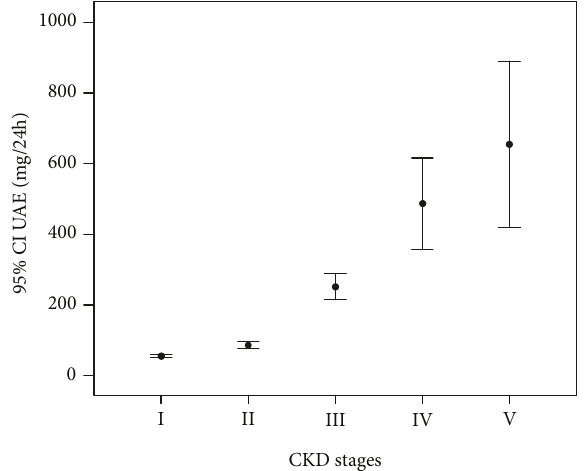
Figure 2: The mean and 95% CI of UAE in 5936 participants in type 2 diabetes without overt thyroid dysfunction according to di ff erent CKD stages.